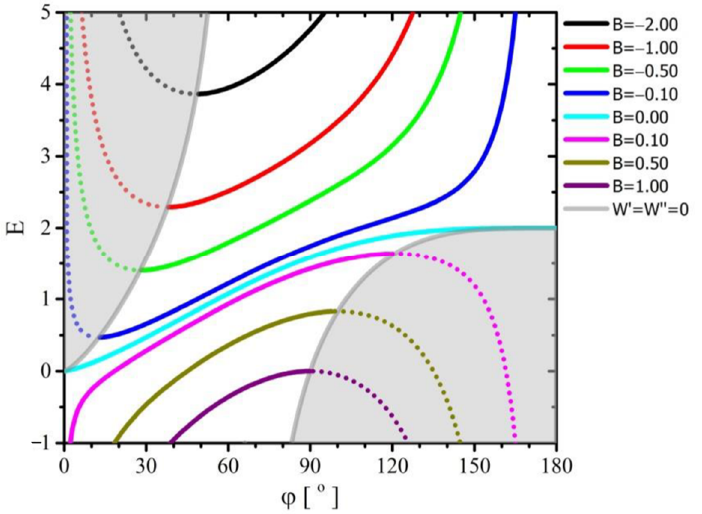
Figure 4. Dependence of the E = ε R π parameter on the contact angle for several values of the B = σ FI σ CI parameter—the equilibrium of forces acting on the droplet. The gray area marks solutions to the unstable equilibrium of forces.